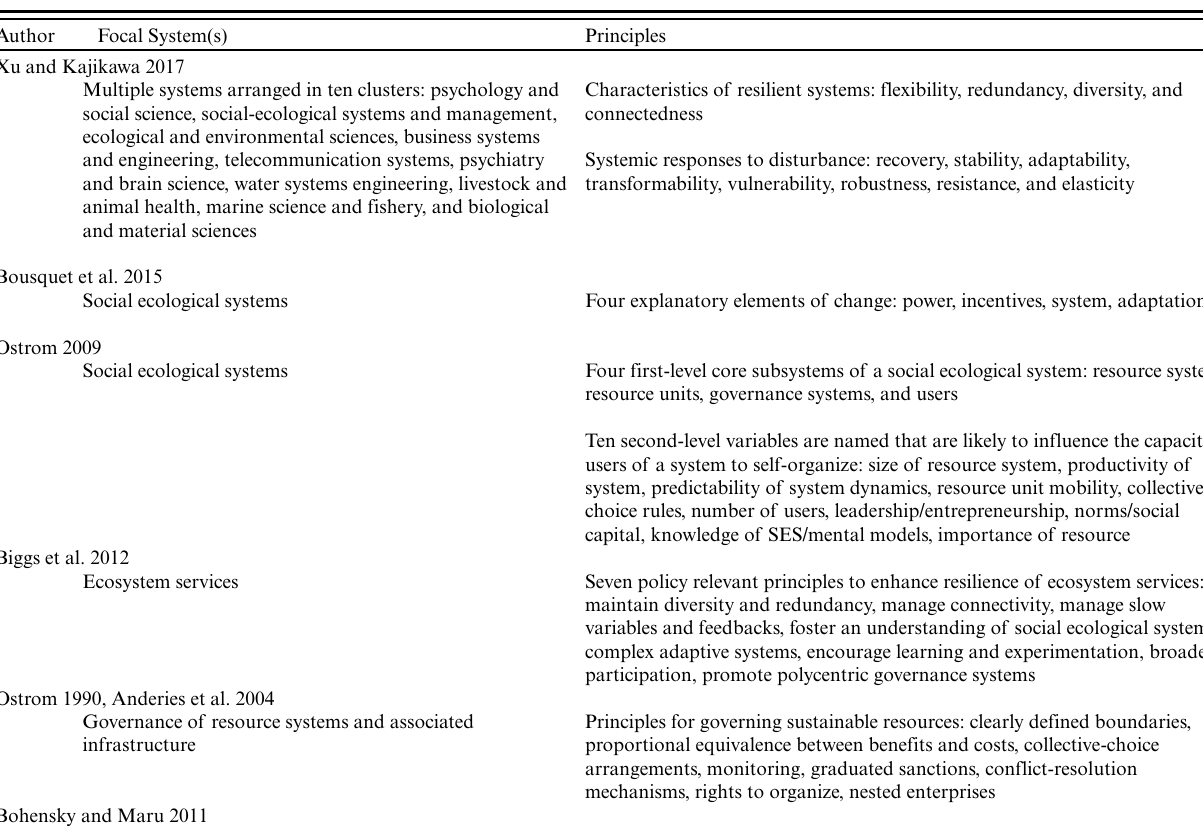
Table 1. Syntheses and metasyntheses of the resilience literature: a purposeful sample, by date and focal